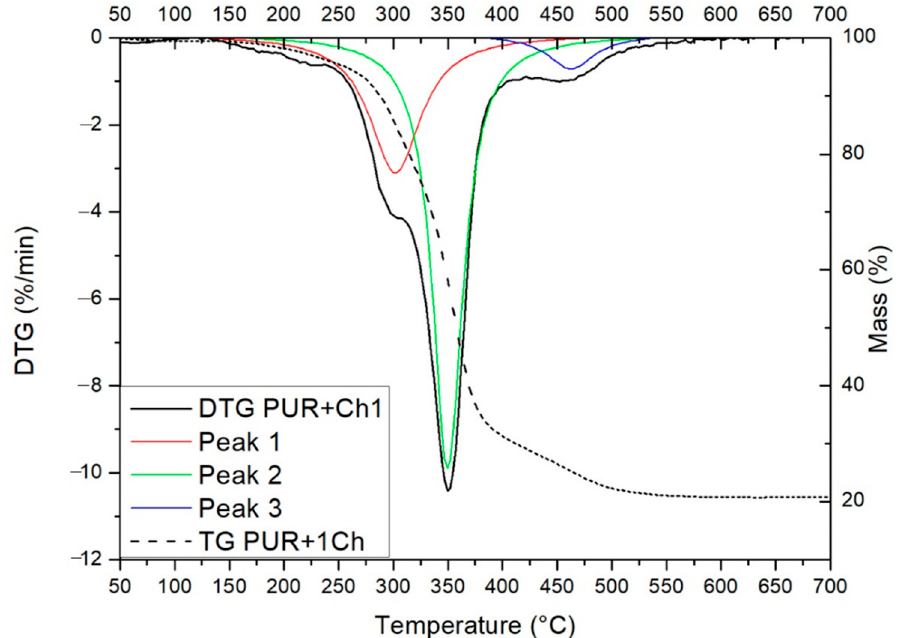
Figure 4. TGA and DTA curves of PUR+Ch1. Table 5. Results of TGA analysis.